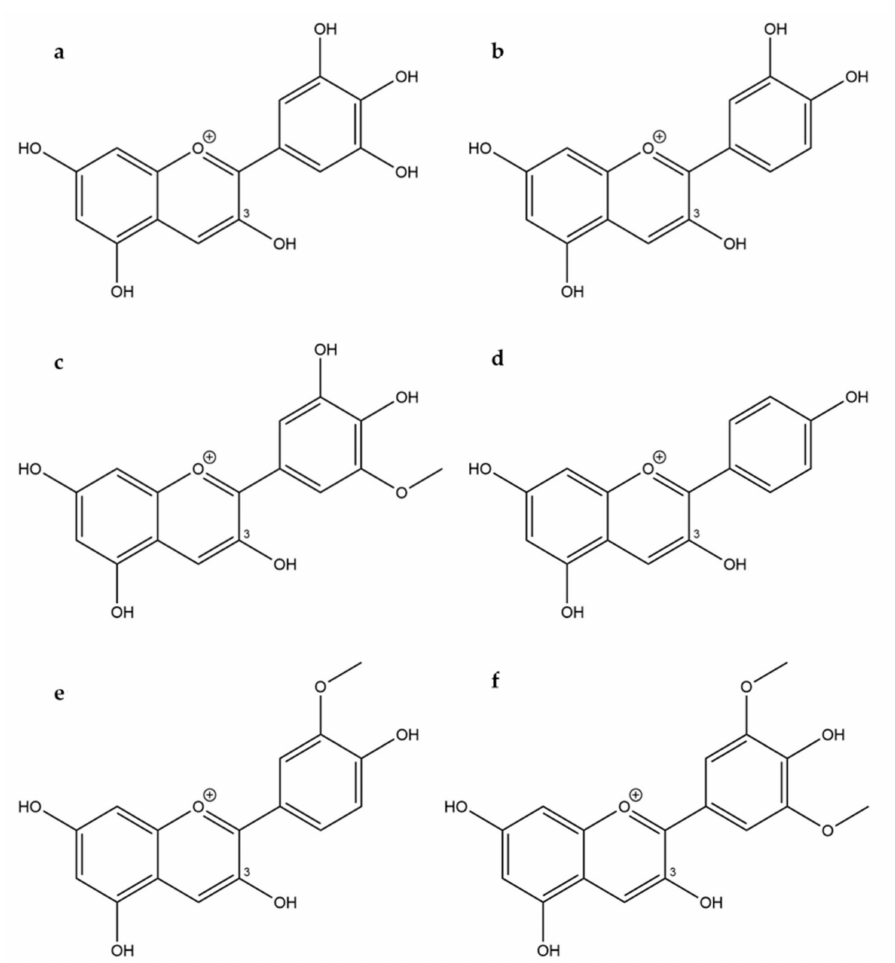
Figure 1. Structures of ( a ) delphinidin, ( b ) cyanidin, ( c ) petunidin, ( d ) pelargonidin, ( e ) peonidin, and ( f )